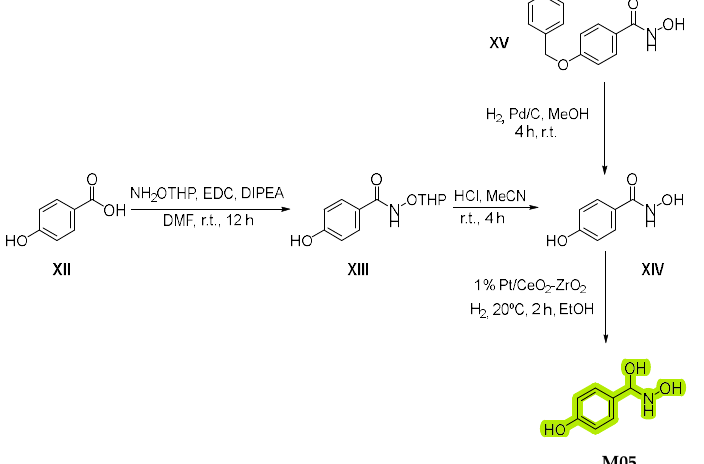
Figure 17. Theoretical synthetic route for the preparation of M05 . Starting materials XII and XV are commercially available.